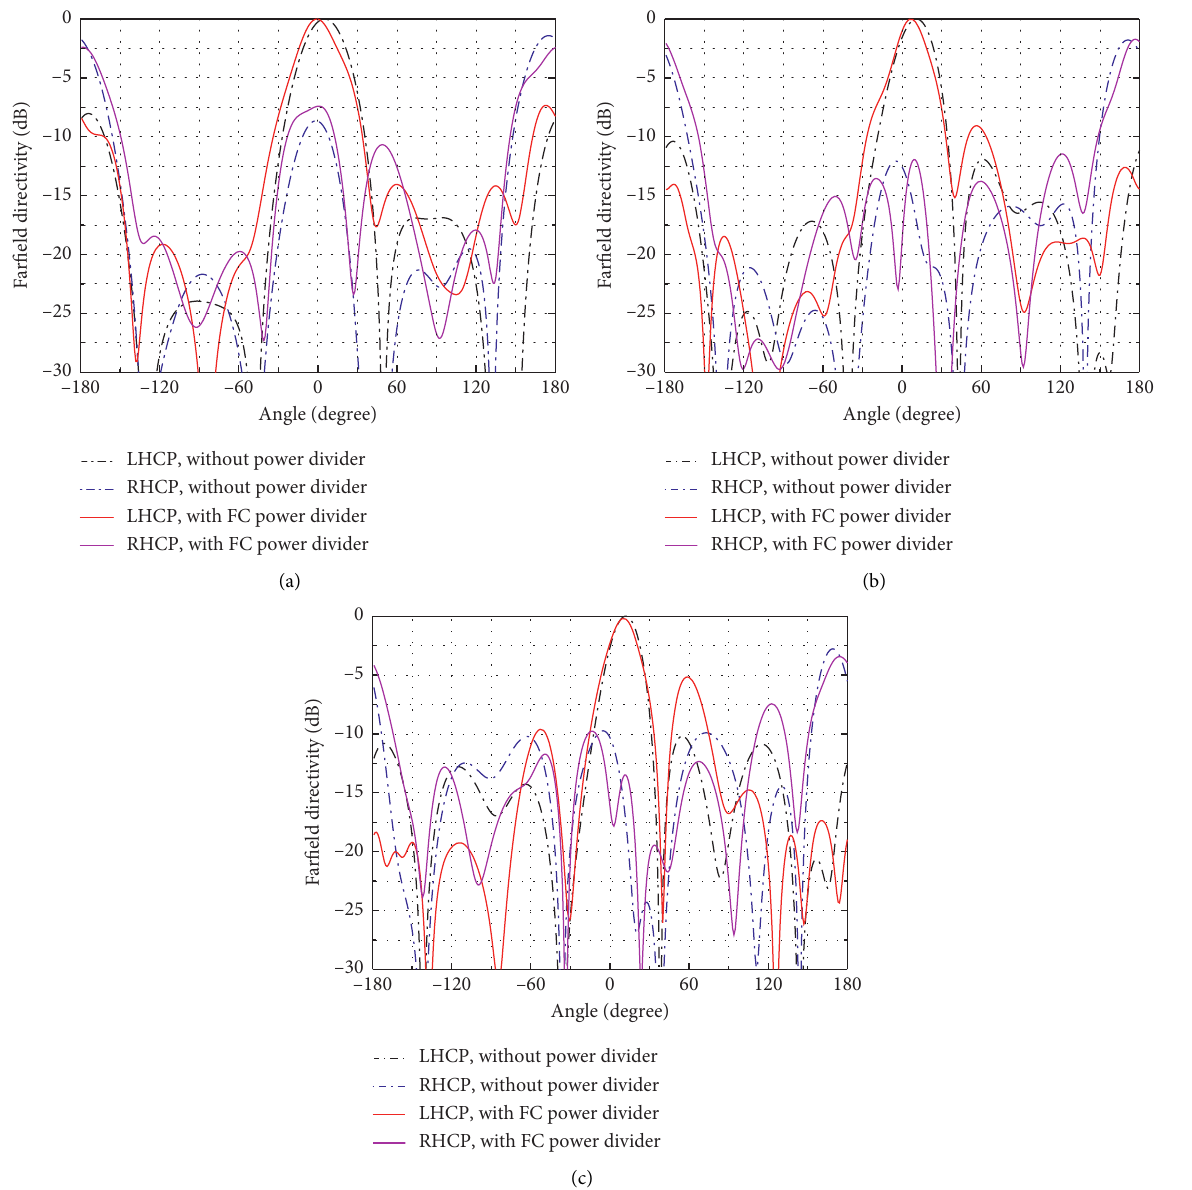
Figure 5: Simulatedradiationpatternsoftheproposedarraywithandwithoutapowerdivider:(a)radiationpatternsat25GHz,(b)radiationpatterns at 28GHz, and (c) radiation patterns at 31GHz.